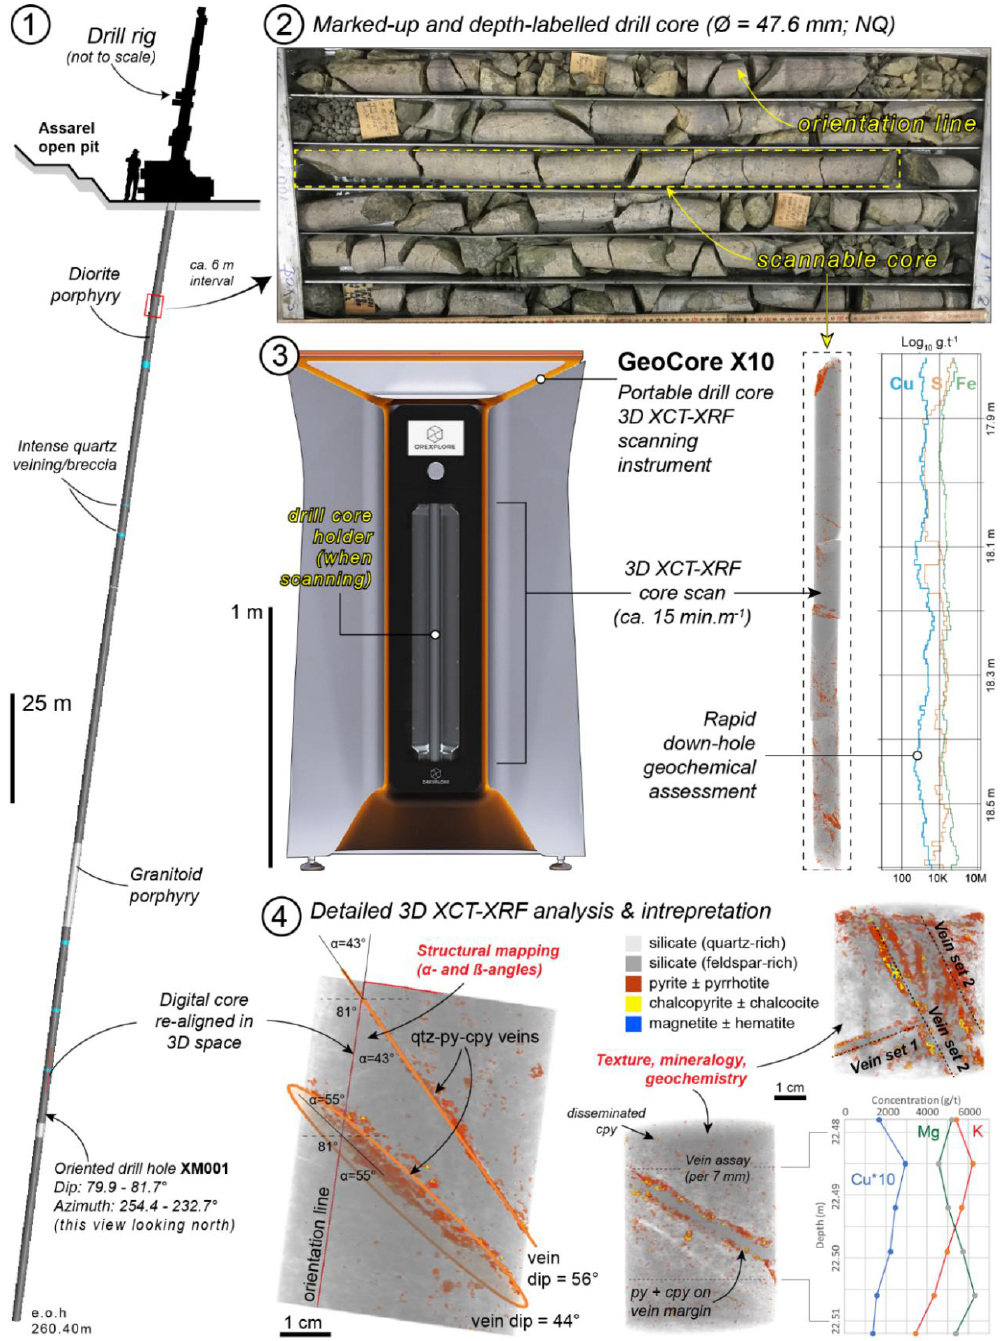
Figure 1. Drill core 3D X-ray computed tomography–X-ray fluorescence (XCT-XRF) scanning technology being developed within the X-MINE project. In this example from Assarel, a proposed workflow for the assessment of a new drill hole (XM001) is illustrated where; drilling and marking of oriented drill core is performed, producing down-hole 3D tomographic imagery and geochemistry (Step 3), and the measurement of geological structures and interpretation of textures, mineralogy and geochemistry is done (Step 4). Abbreviations: cpy = chalcopyrite, py = pyrite, qtz =